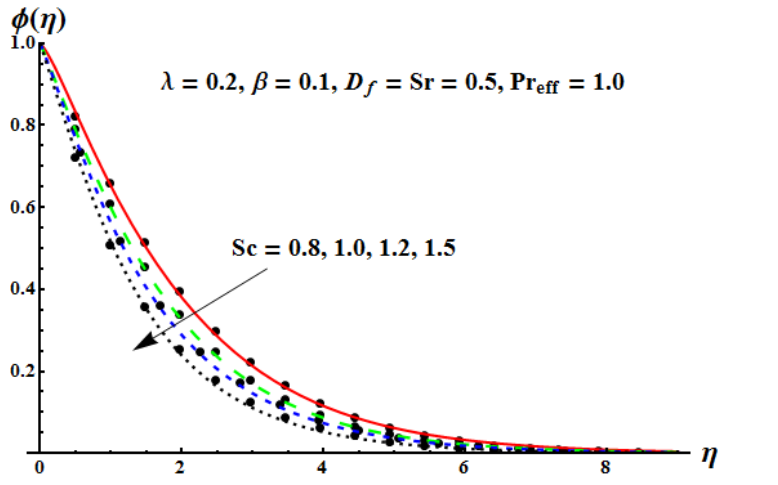
Figure 18. Influence of Sc on φ ( η ) . Solid line: OHAM solution, solid circles: numerical solution.